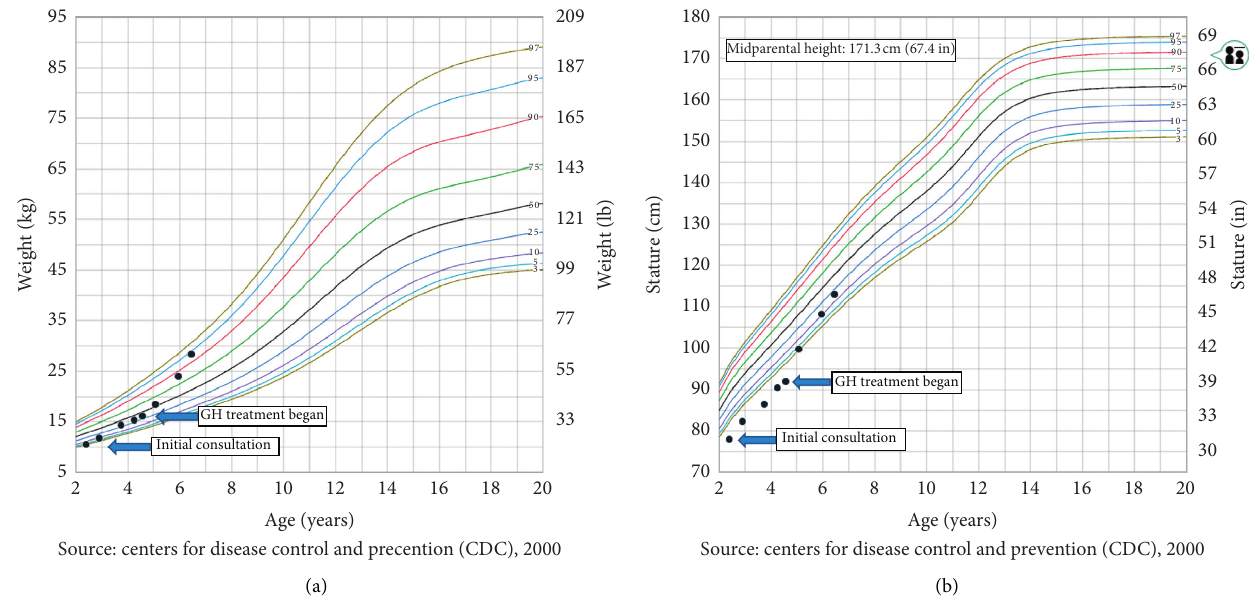
Figure 1: The weight (a) and height (b) data, at the time of initial consultation and when the growth hormone treatment has begun, indicated by arrows. GH, growth hormone. Table 1: Laboratory results of selected biomarkers of the patient before and after growth hormone